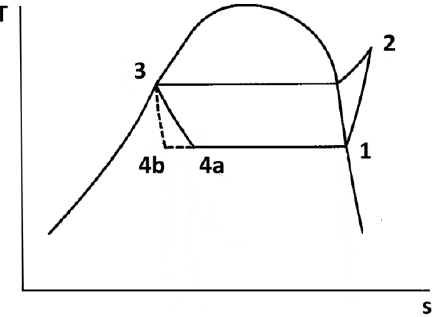
Figure 4. T – s diagram of vapor compression refrigeration cycle. Here, 3 – 4a is the throttling valve, Figure 4. T–s diagram of vapor compression refrigeration cycle. Here, 3–4a is the throttling valve, and 3 – 4b is the two-phase expander. and 3–4b is the two-phase